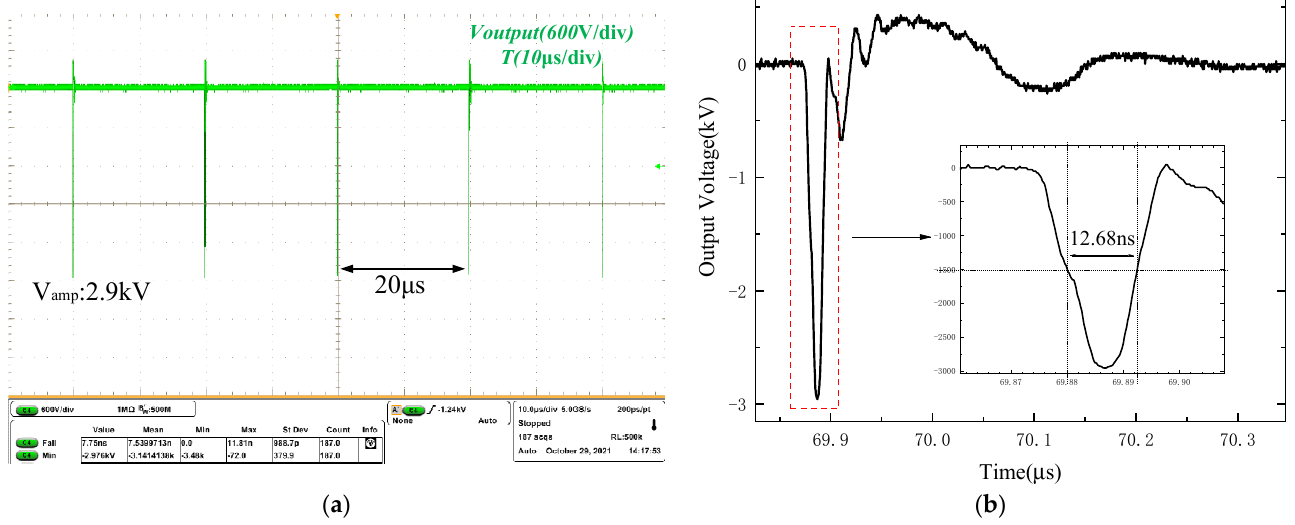
Figure 8. The voltage waveform of the load (circuit I): ( a ) discharge waveform with a repeatable frequency of 50 kHz; ( b ) enlarged view of load voltage.